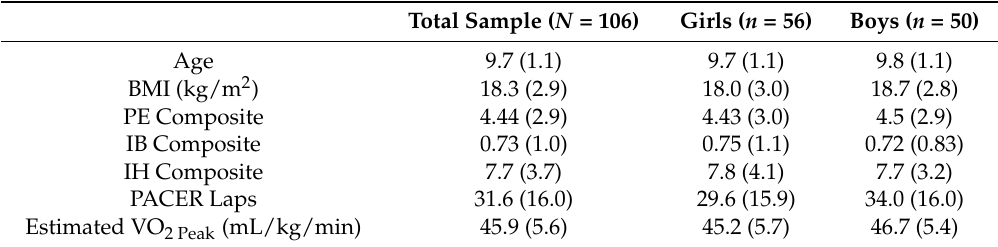
Table 1. Descriptive statistics for the total sample and within sex groups (means and standard